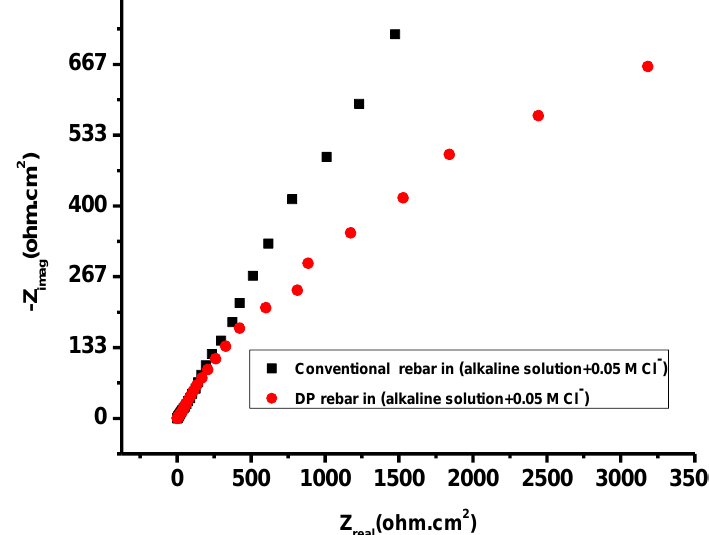
Figure 8. EIS Nyquist curve in an alkaline solution + 0.02 M Cl − ions. EIS, electrochemical impedance spectroscopy.